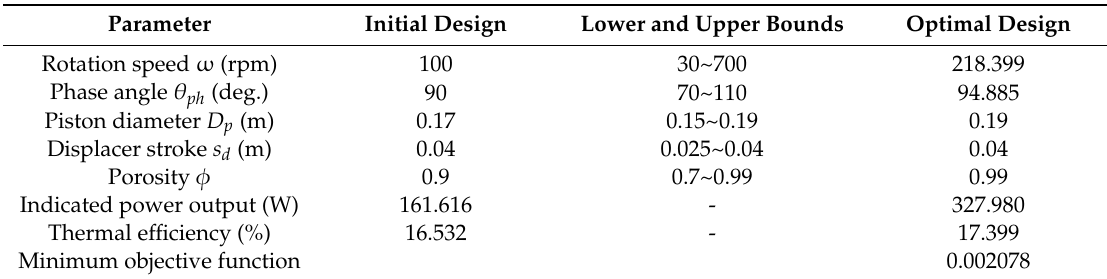
Table 5. Parameters with five-parameter optimization.